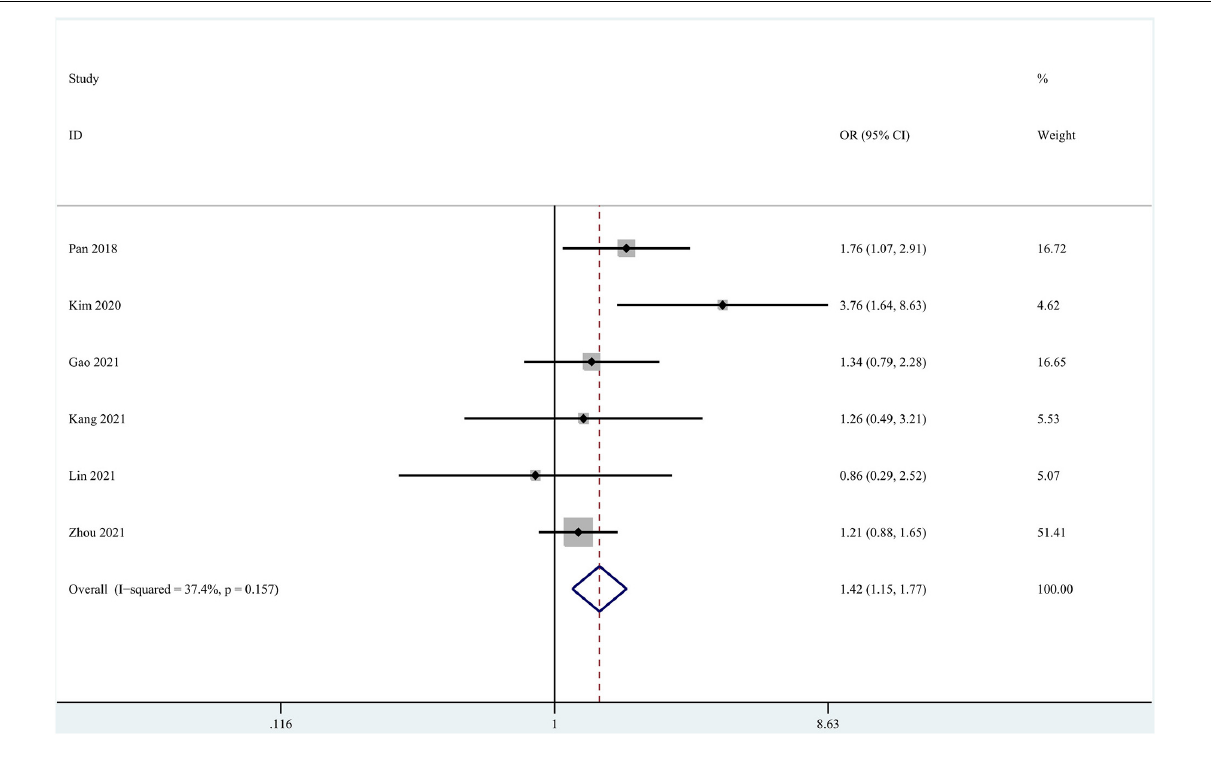
FIGURE 4 | Forest plot of the accuracy in the task of AD vs. CN classification.